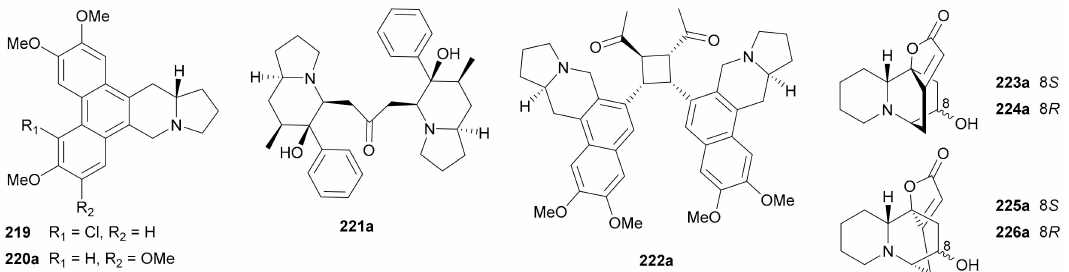
Figure 13. Structures of indolizidine and quinolizidine